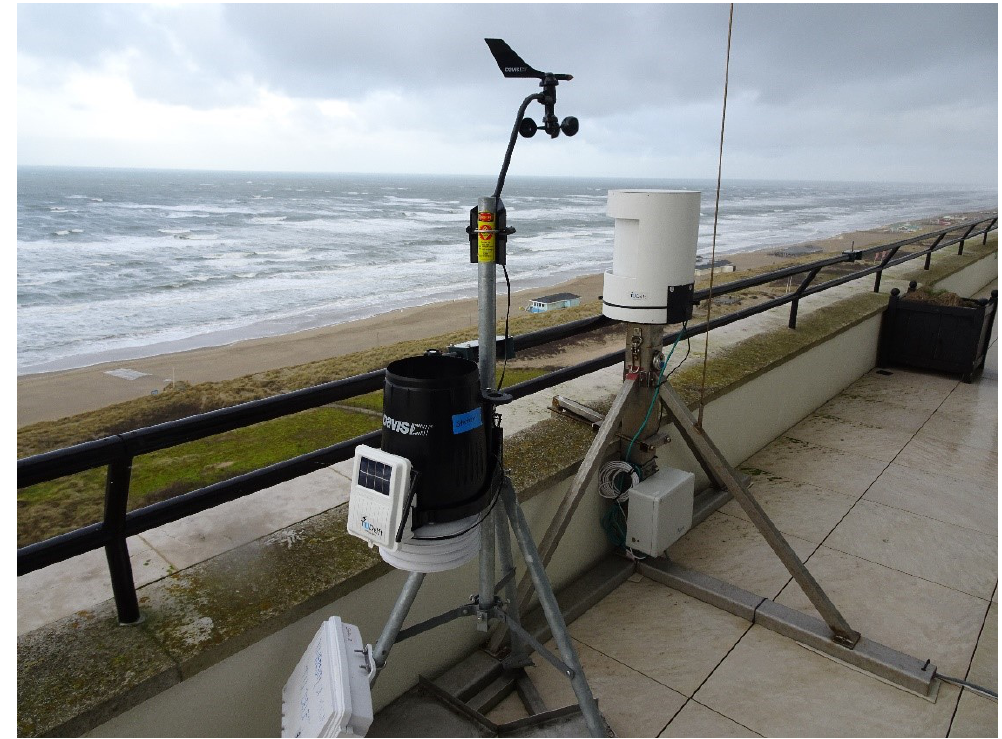
Figure 1. TLS and the weather station installed on the upper balcony of the Huis ter Duin Hotel, Noordwijk, the